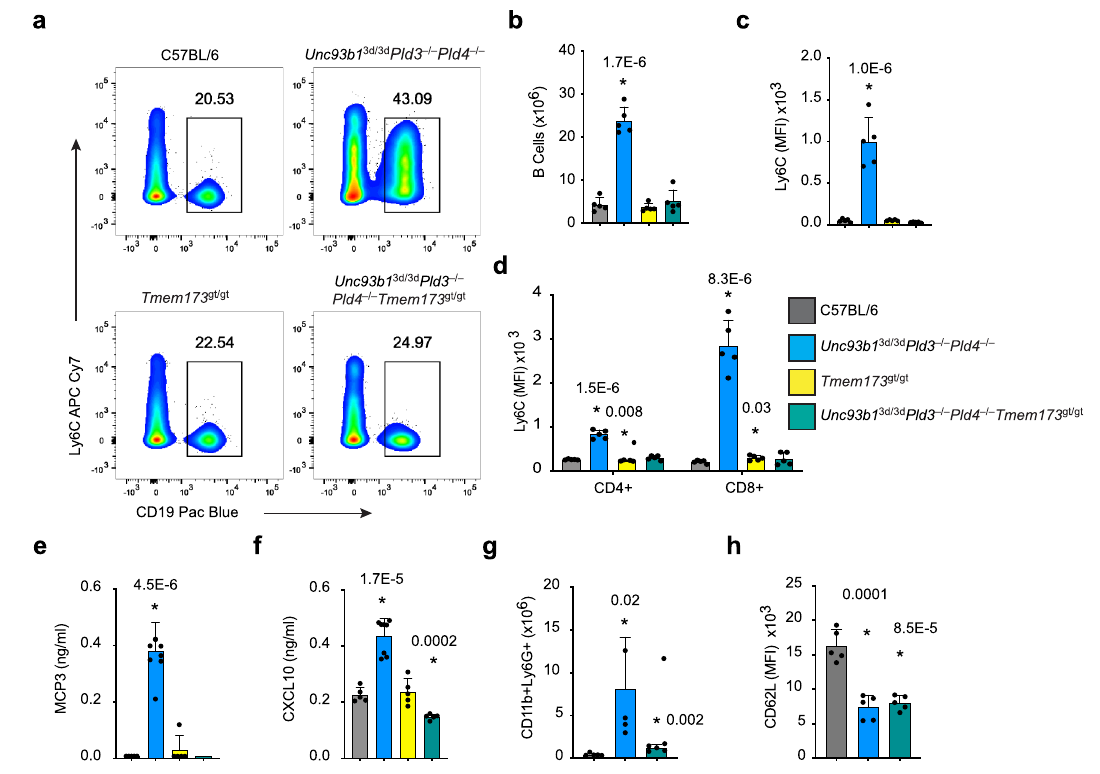
Fig. 8 STING-driven increase of Ly6C, MCP3, CXCL10, and neutrophils in Unc93b1 3d/3d Pld3 − / − Pld4 − / − mice. Mice of the indicated genotypes were assessed for the expression levels of Ly6C on B and T cells from lymph nodes. a – c Analysis of B cells. d Ly6C levels on CD4 + and CD8 + T cells. Analysis of concentration of e MCP3 and f CXCL10 in sera of indicated mice. Splenic neutrophils were assessed for g number and h surface expression of CD62L. Bar graphs show mean ± SD with each symbol representing an individual mouse. Unpaired two-tailed T -tests were performed by comparing groups to C57BL/ 6. These experiments were performed at least twice with similar results. In most experiments, fi ve independent mice were analyzed per group, except for e , f , where eight mice were in the Unc93b1 3d/3d Pld3 − / − Pld4 − / −